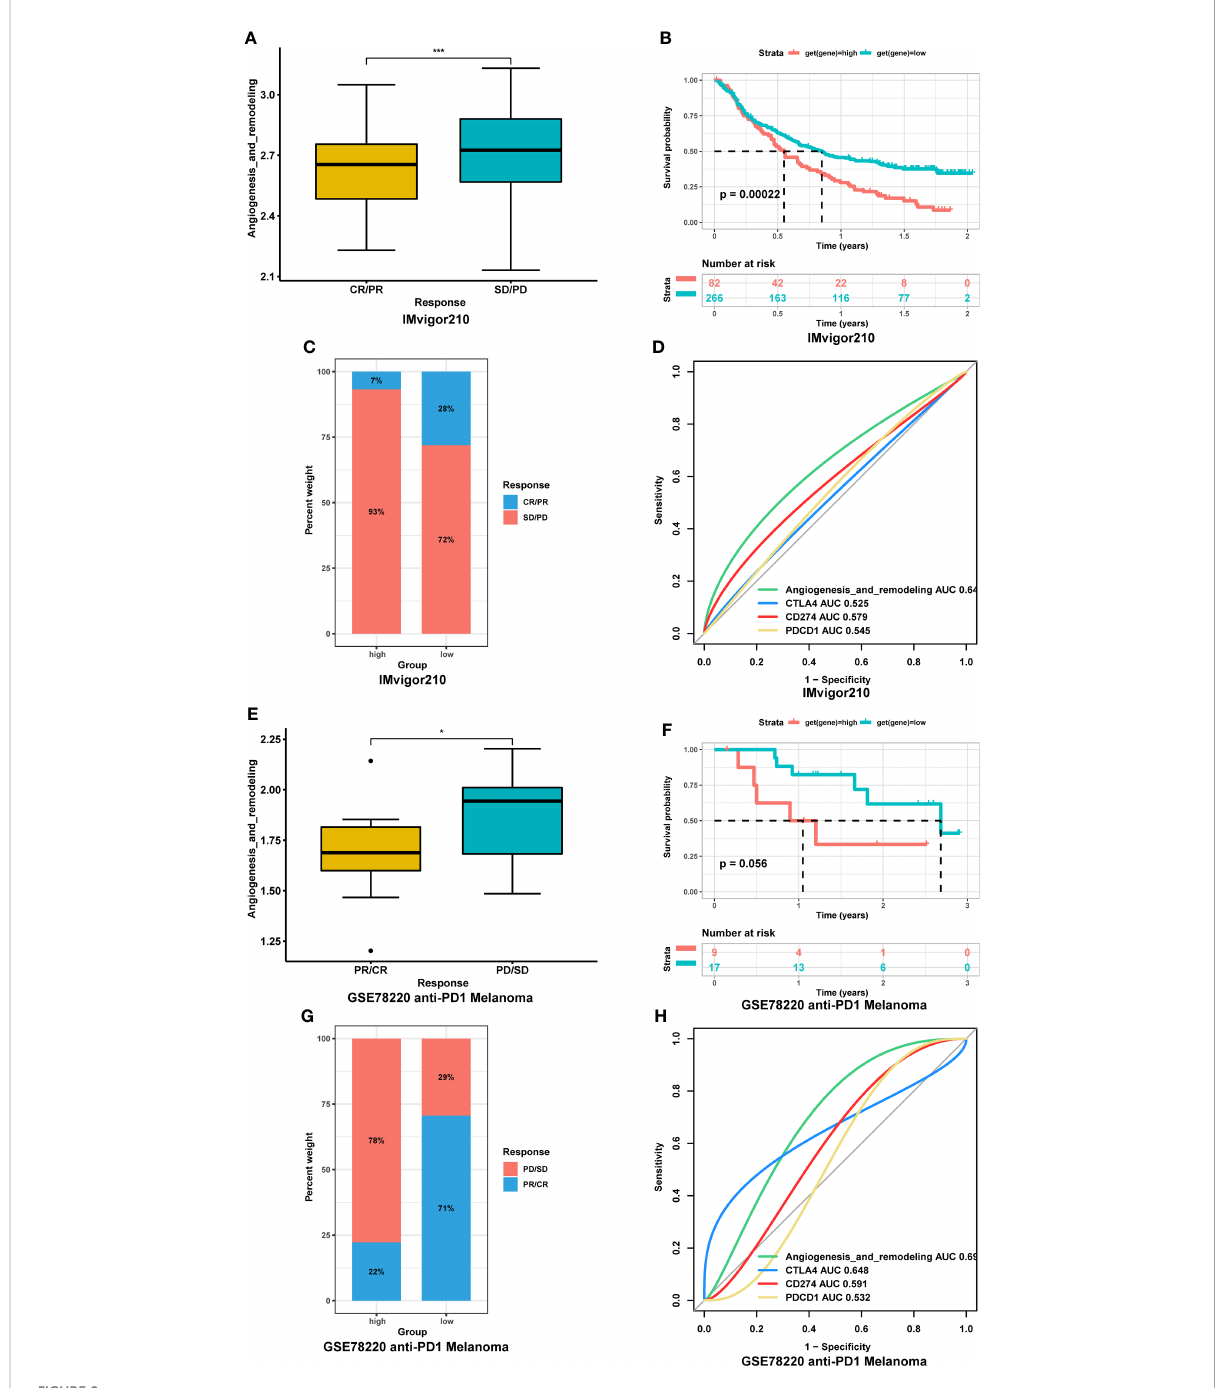
FIGURE 9 Association between the AR score and immunotherapy response. (A) Correction between the AR score and immunotherapy response in IMvigor210 cohort. (B) Kaplan-Meier curve of overall survival between high- and low-AR score in IMvigor210 cohort. (C) Proportions of complete response/partial response (CR/PR) and stable disease/progressive disease (SD/PD) patients in high- and low-AR score groups in IMvigor210 cohort. (D) The receiver operating characteristic (ROC) curve of the AR score and immune checkpoints in IMvigor210. (E) Correction between the AR score and immunotherapy response in GSE78220 cohort. (F) Kaplan-Meier curve of overall survival between high- and low-AR score in GSE78220 cohort. (G) Proportions of CR/PR and SD/PD patients in high- and low-AR score groups in GSE78220 cohort. (H) The ROC curve of the AR score and immune checkpoints in GSE78220 cohort. *P < 0.05, ***P <